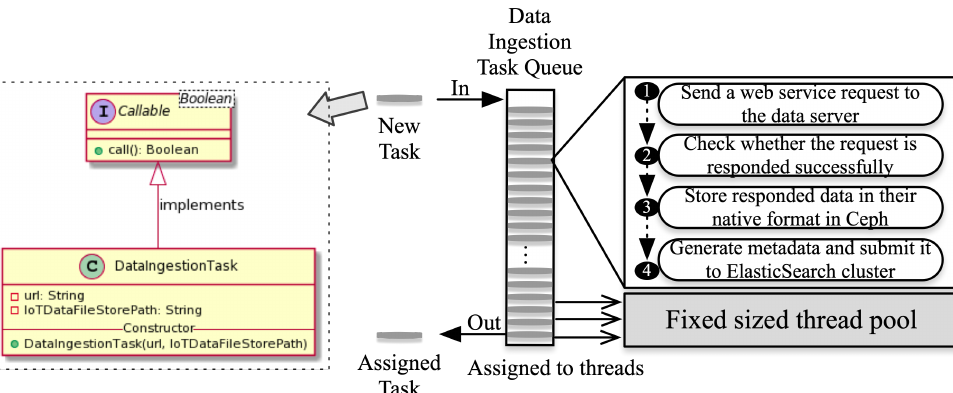
Figure 3. Multithreading parallel data ingestion method.